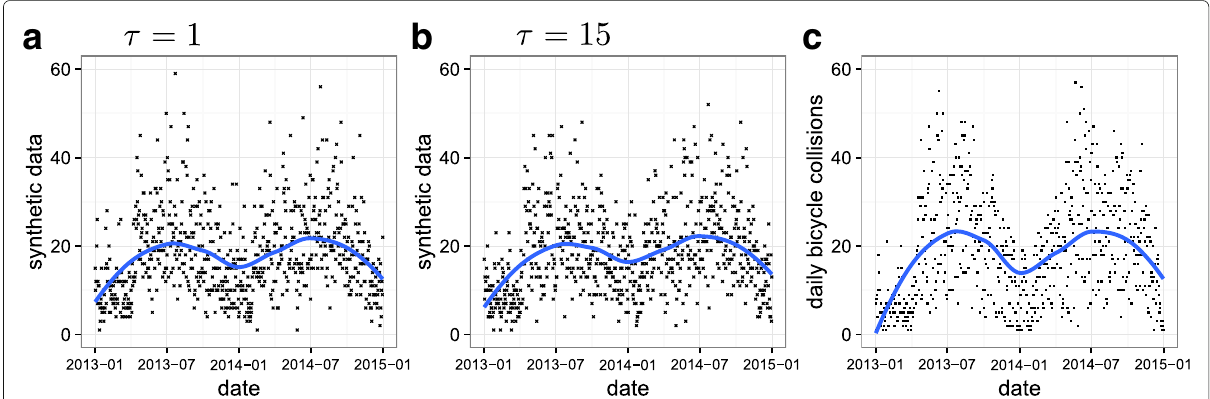
Fig. 2 Synthesized crash data [in ( a ) without memory and in ( b ) with memory] and real crash data [in ( c )]. A smoothing local regression fit is shown to guide the